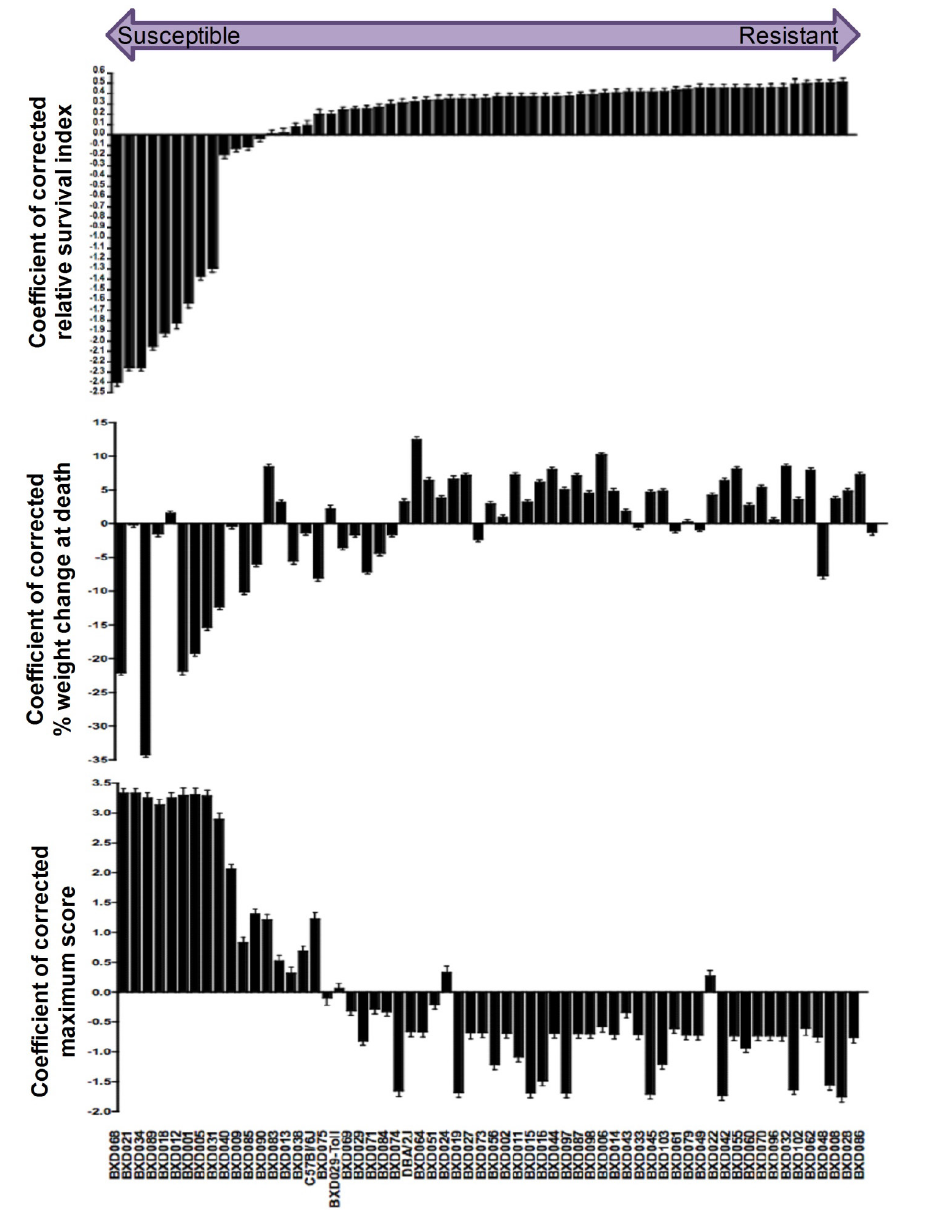
Figure 7. Differential susceptibility of recombinant and advanced recombinant inbred BXD strains & their parental strains post-exposure to aerosolized MA-EBOV. Rank-ordered bar chart of differential survival of 60 BXD strains and their parental strains (n= 586 mice) expressed as coefficient of mean corrected relative survival index. Top panel: Strains are arranged from highly susceptible on the left-hand side to intermediate and finally highly resistant on right-hand side. Middle Panel: Variation in percent of body weight loss at death. Bar chart showing coefficient of mean corrected percent of body weight loss at death arranged in order of differential survival. Bottom Panel: Variation in maximum clinical disease score. Bar chart shows coefficient of mean corrected maximum score arranged in order of differential survival. Error bars represent standard error of the coefficient. Total number of mice used per strain is indicated in Table S1 (Supplemental Information). Statistical test used is two-way ANOVA with correction to covariates as detailed in methods